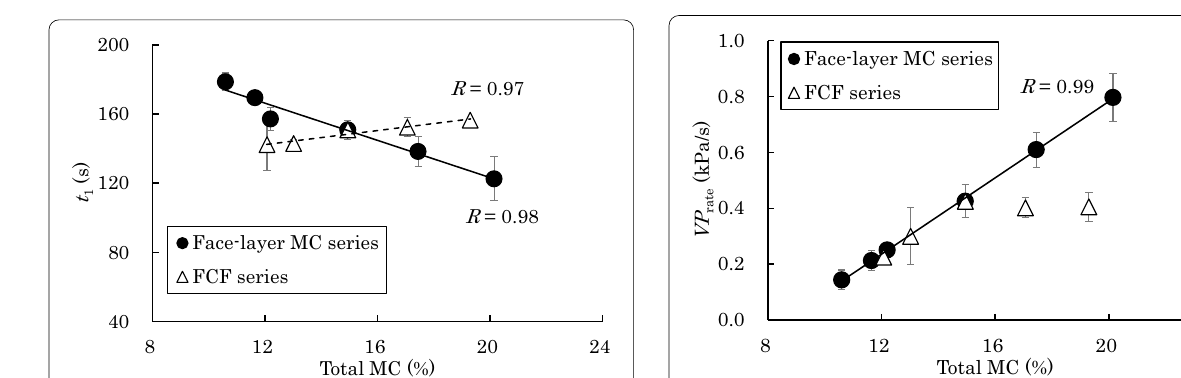
Fig. 7 Relationship between VP rate and total MC for the mat in the face-layer MC and FCF series: the solid line is the regression line of